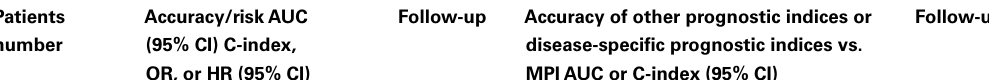
disease-specific prognostic indices